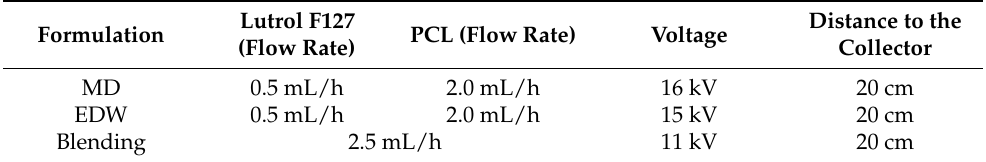
Table 2. Electrospinning parameters for each